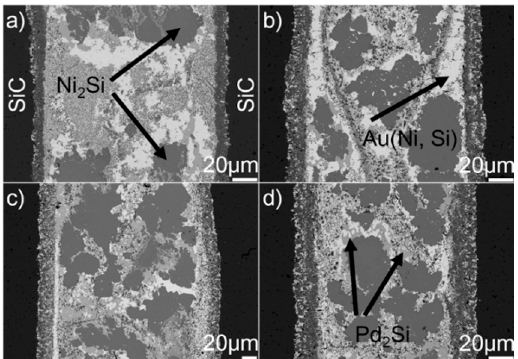
Figure 8. BSE images indicating the microstructure of the SiC/SiC joints brazed at 1523 K for different soaking times: ( a ) 10 min; ( b ) 30 min; ( c ) 60 min; ( d ) 90 min.